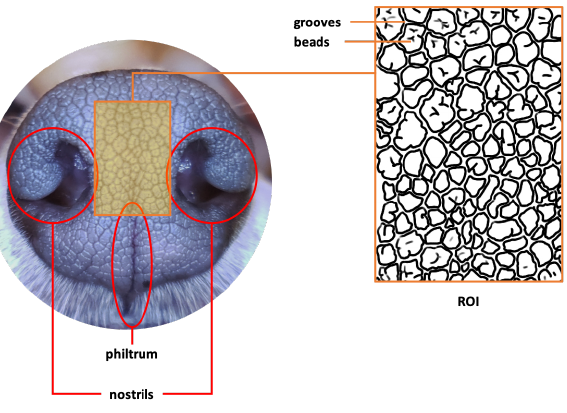
Figure 1. Canine nose and nose pattern in ROI (replicated with permission by the copyright